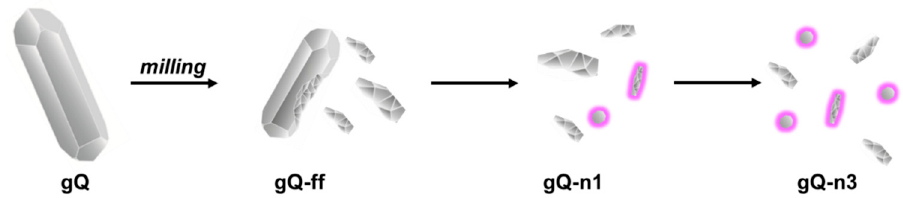
Figure 5. Mechanism of quartz fracturing induced by planetary milling in a wet environment. Pro- longed millings cause abrasion of the larger crystals, promoting the formation of nanoparticles, and induce amorphization of the nanoquartz fraction, highlighted with a purple halo. Size of crystallites is not in scale.